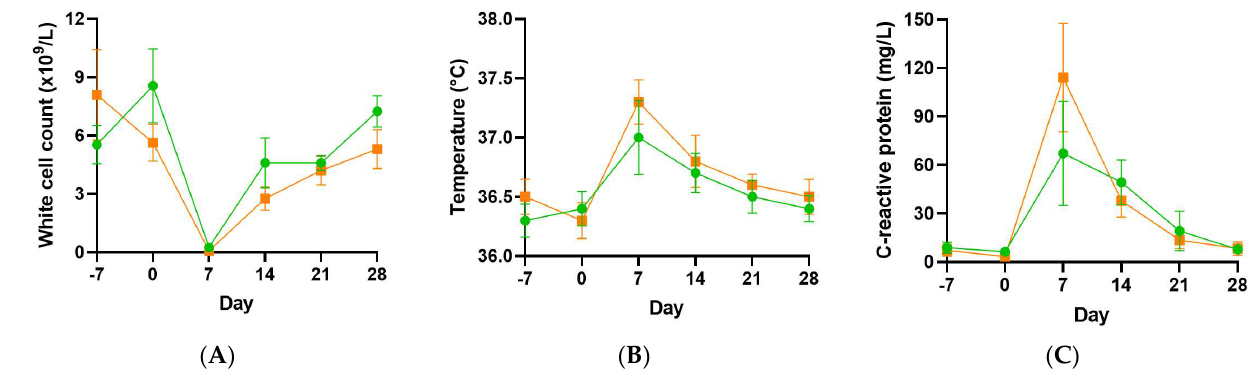
Figure 3. Infection parameters in the vitamin C and placebo groups. White cell counts ( A ), temper- ature ( B ) and C-reactive protein concentrations ( C ). Placebo group, green circles; vitamin C group, orange squares.